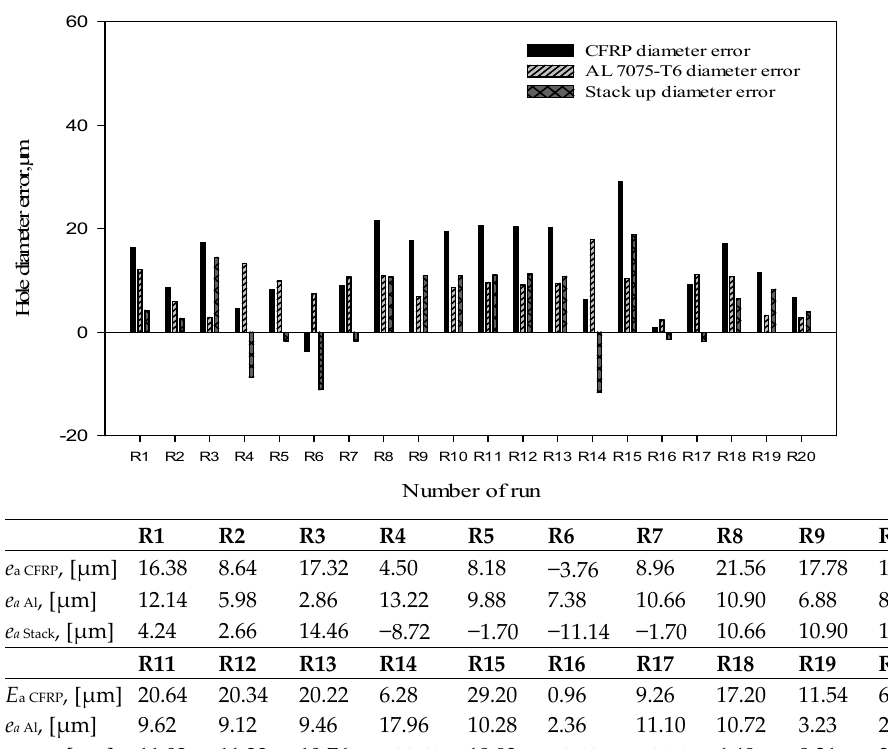
18 of 23 Figure 17. Proposed solution report for the optimization tool geometry process. Table 7. Prediction of the optimized model of twist drill bit for edge defect analysis when drilling CFRP/Al7075-T6 stack-up material. Responses (Y)